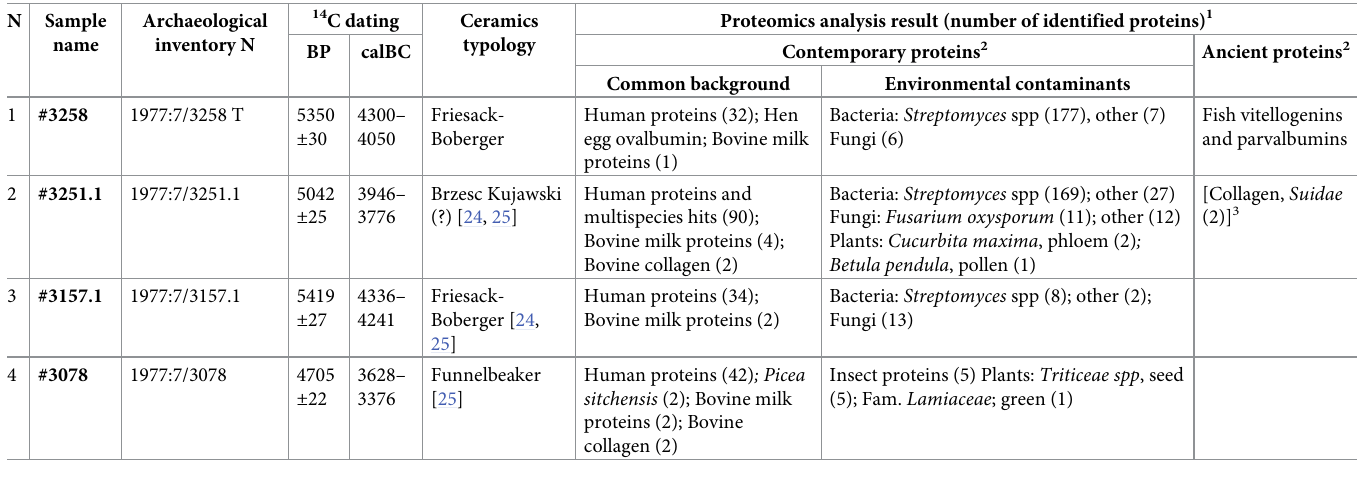
Table 1. Overview of Friesack 4